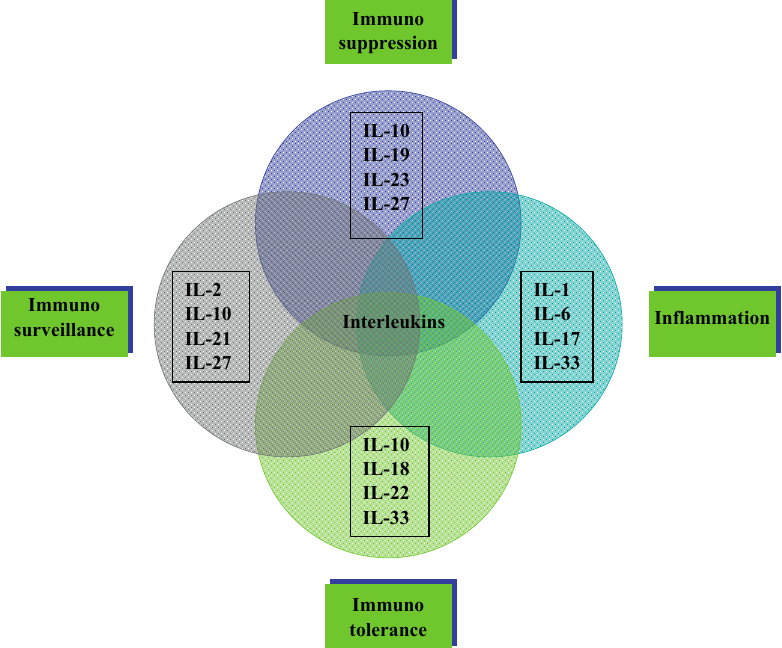
Figure 3. The major immune system-related interwoven roles of cytokine interleukins in the various stages of